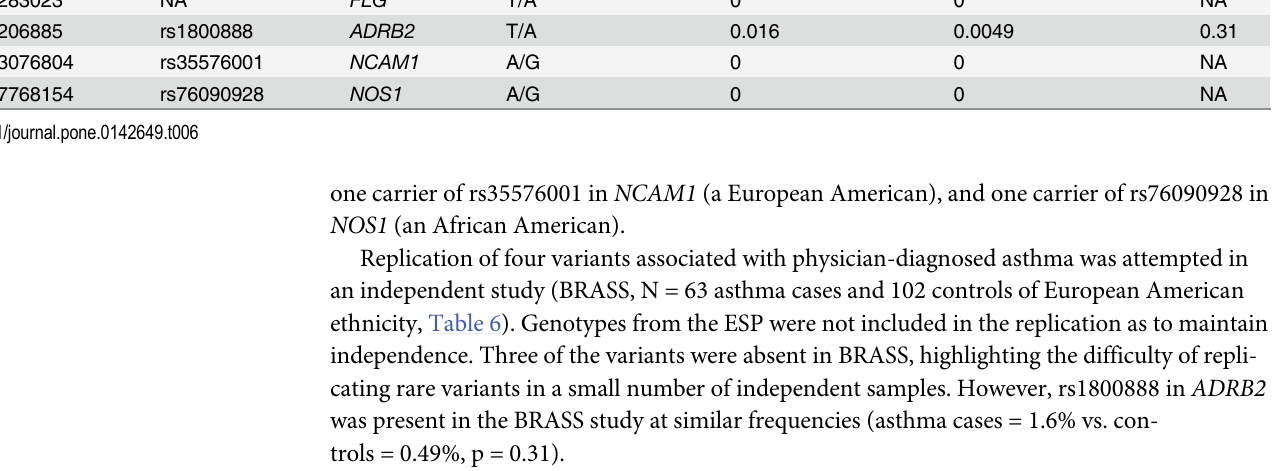
Table 6. Results of replication in the BRASS study of four variants associated with asthma following severe RSV bronchiolitis in infancy (number of asthma cases = 81, number of asthma controls = 126). Position (hg19)